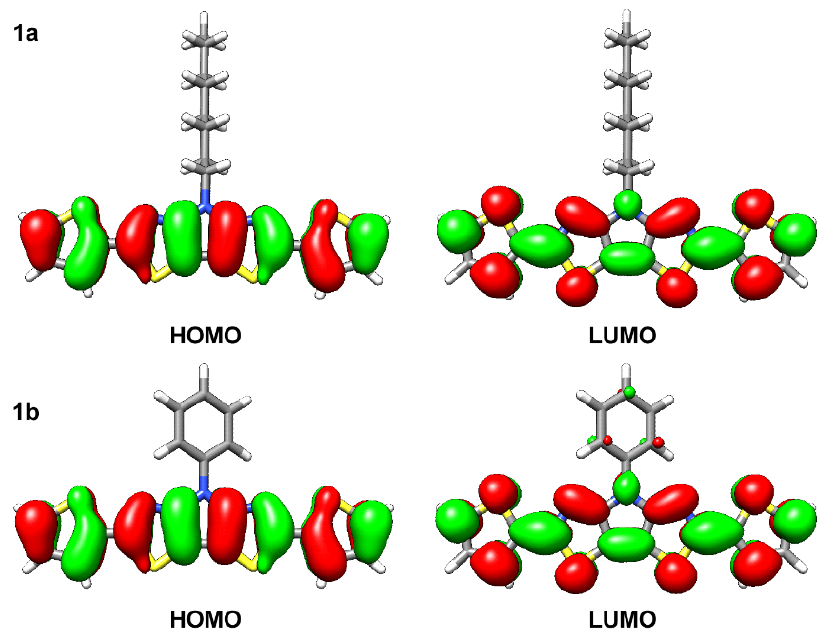
Figure 9. Electronic density contours, calculated at PBE0/6-31G** level, for the frontier molecular orbitals of 1a and 1b .